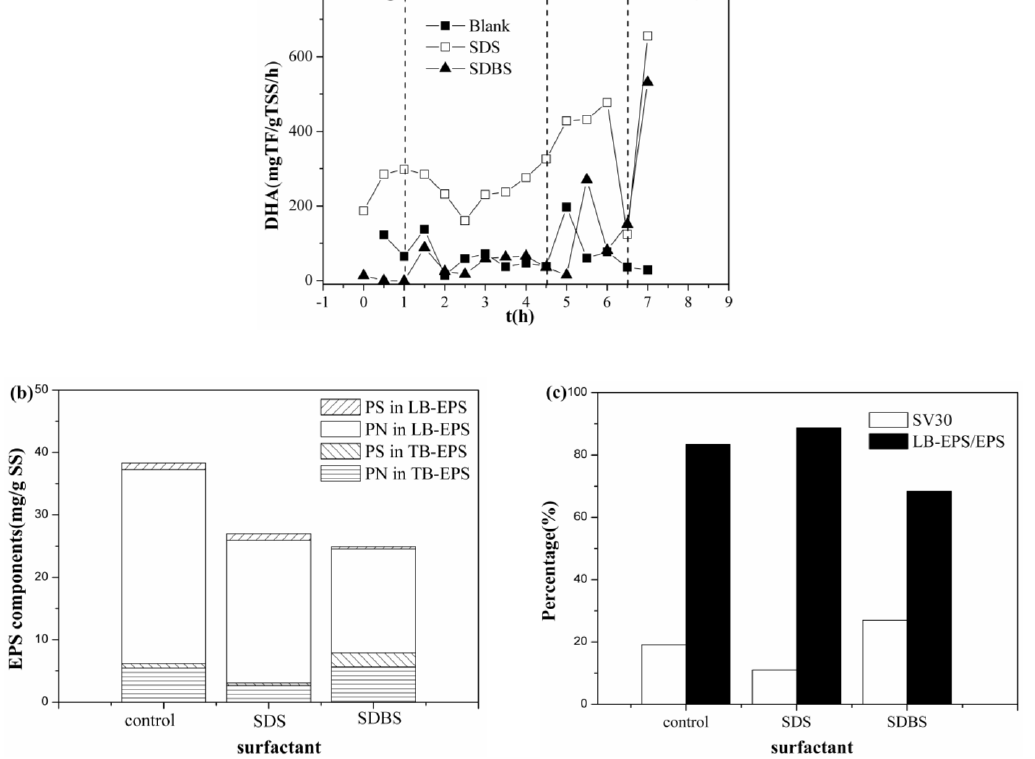
Figure 2. Variation of activated sludge characteristics under different surfactants: ( a ) dehydrogenase activity (DHA); ( b ) extracellular polymer substance (EPS); and ( c ) Sedimentation performance.